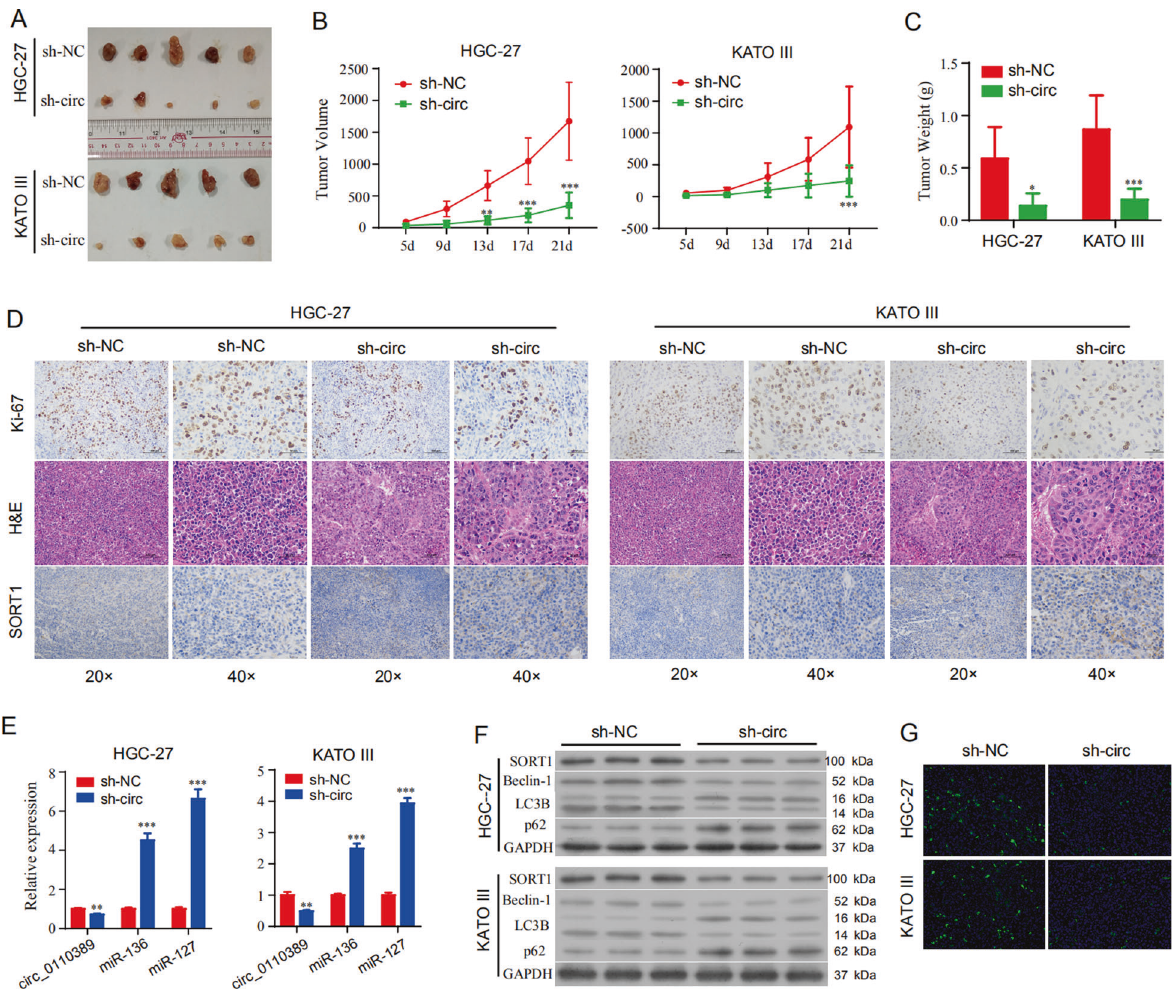
Fig. 7 Knockdown of hsa_circ_0110389 inhibits growth of GC tumor in vivo. A – C Schematic representation ( A ), in vivo growth curve ( B ), and weight at the end points ( C ) of xenograft tumors formed by subcutaneous injection of HGC-27 and KATO III cells stably transfected with sh-NC or sh-circRNA ( n = 5 for each group). D Representative images of H&E staining, Ki-67 staining and IHC for SORT1 of xenograft tumors. E The RNA levels of hsa_circ_0110389, miR-127-5p and miR-136-5p in xenograft tumors were detected by qRT-PCR. F The protein levels of SORT1 and autophagy-related genes (Beclin-1, LC3B and p62) in xenograft tumors by western blot. G The expression of LC3B in xenograft tumors by IF analysis. All data are presented as mean ± SD. * p < 0.05, ** p < 0.01, *** p <